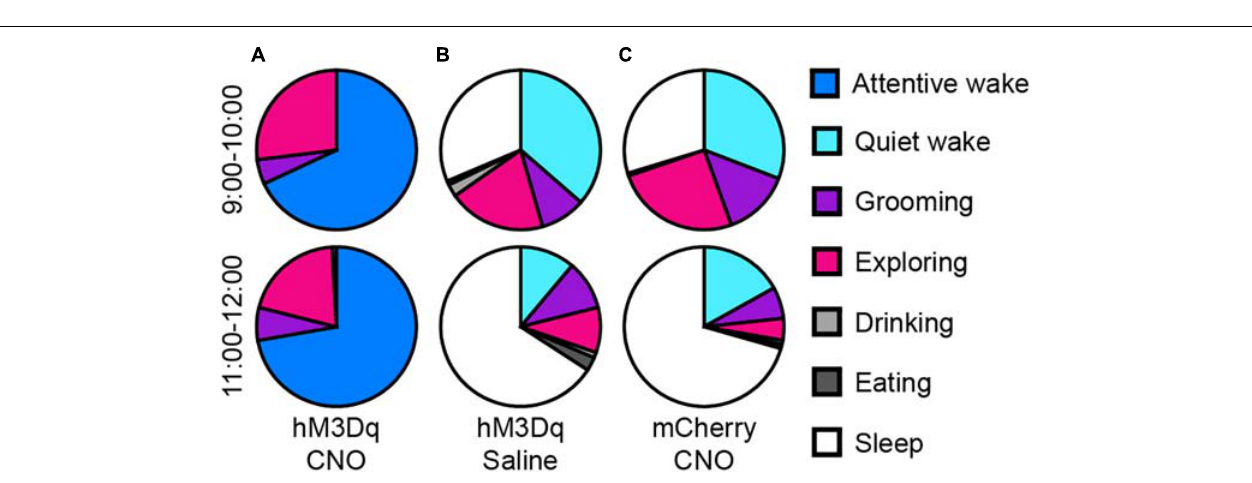
FIGURE 3 | Activation of glutamatergic PB neurons produces attentive wake in rats. After injection of CNO at 9:00, rats are mainly in attentive wake (do not move but with head bobbing) with modest amounts of time spent exploring, grooming, or rearing for more than 10 h (A) . After injection of saline, hM3Dq rats are mainly asleep with a small amount of time in quiet wake and exploring behavior (B) . Injections of CNO in mCherry control rats at 9:00 produced similar behavior to the saline treated hM3Dq rats, mainly asleep with a small amount of time in quiet wake and exploring, grooming, and feeding (C) ( n =